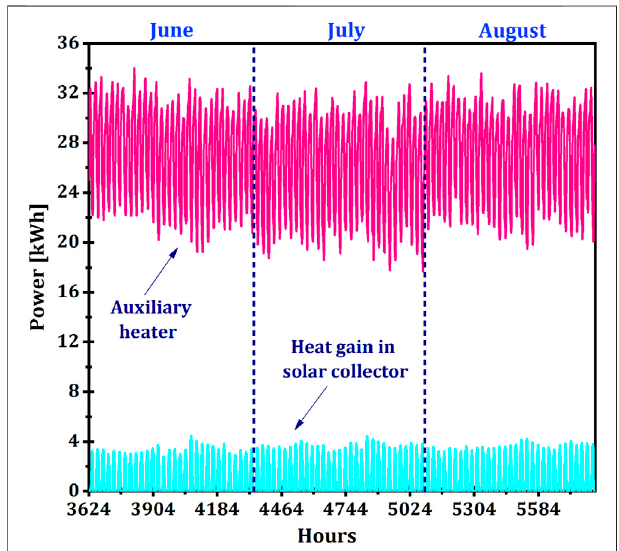
FIGURE 10 | Power usage in an auxiliary heater as well as power gain in a